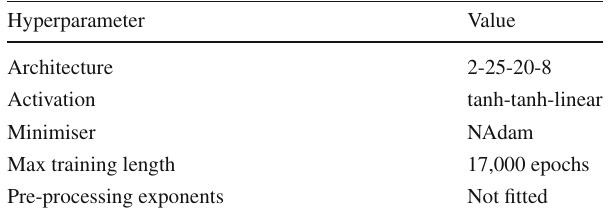
Table 3 Hyperparameters for neural networks used in this study. The parameter choices, and how these choices were made are discussed in Ref. [2]